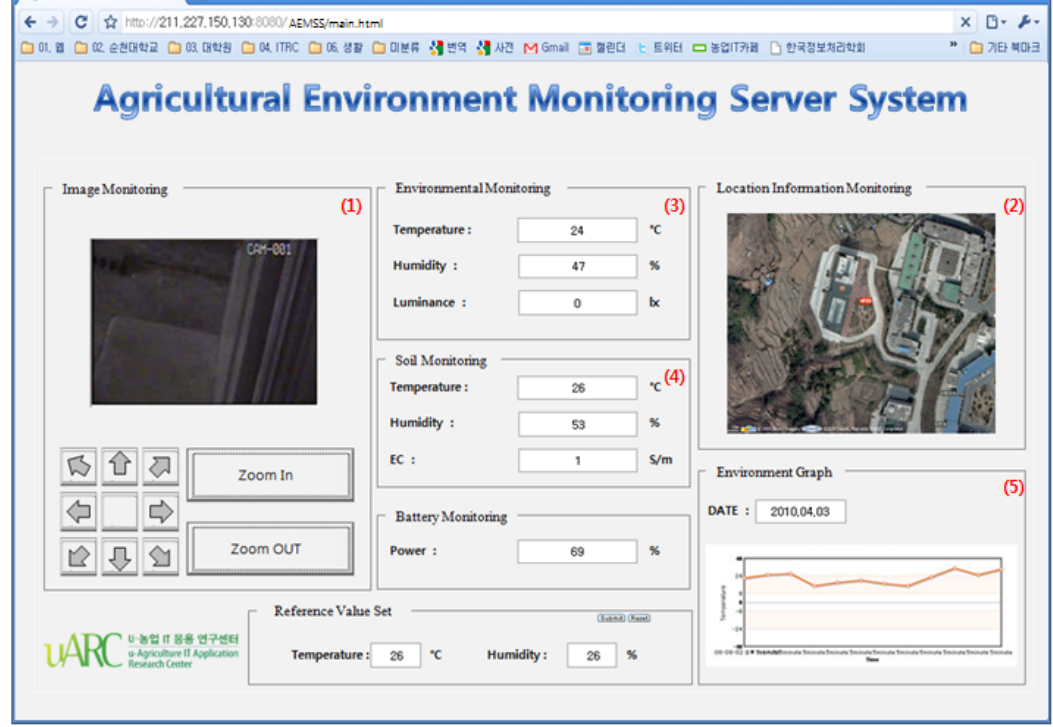
Figure 18. Web GUI for Agricultural Environment Monitoring Server